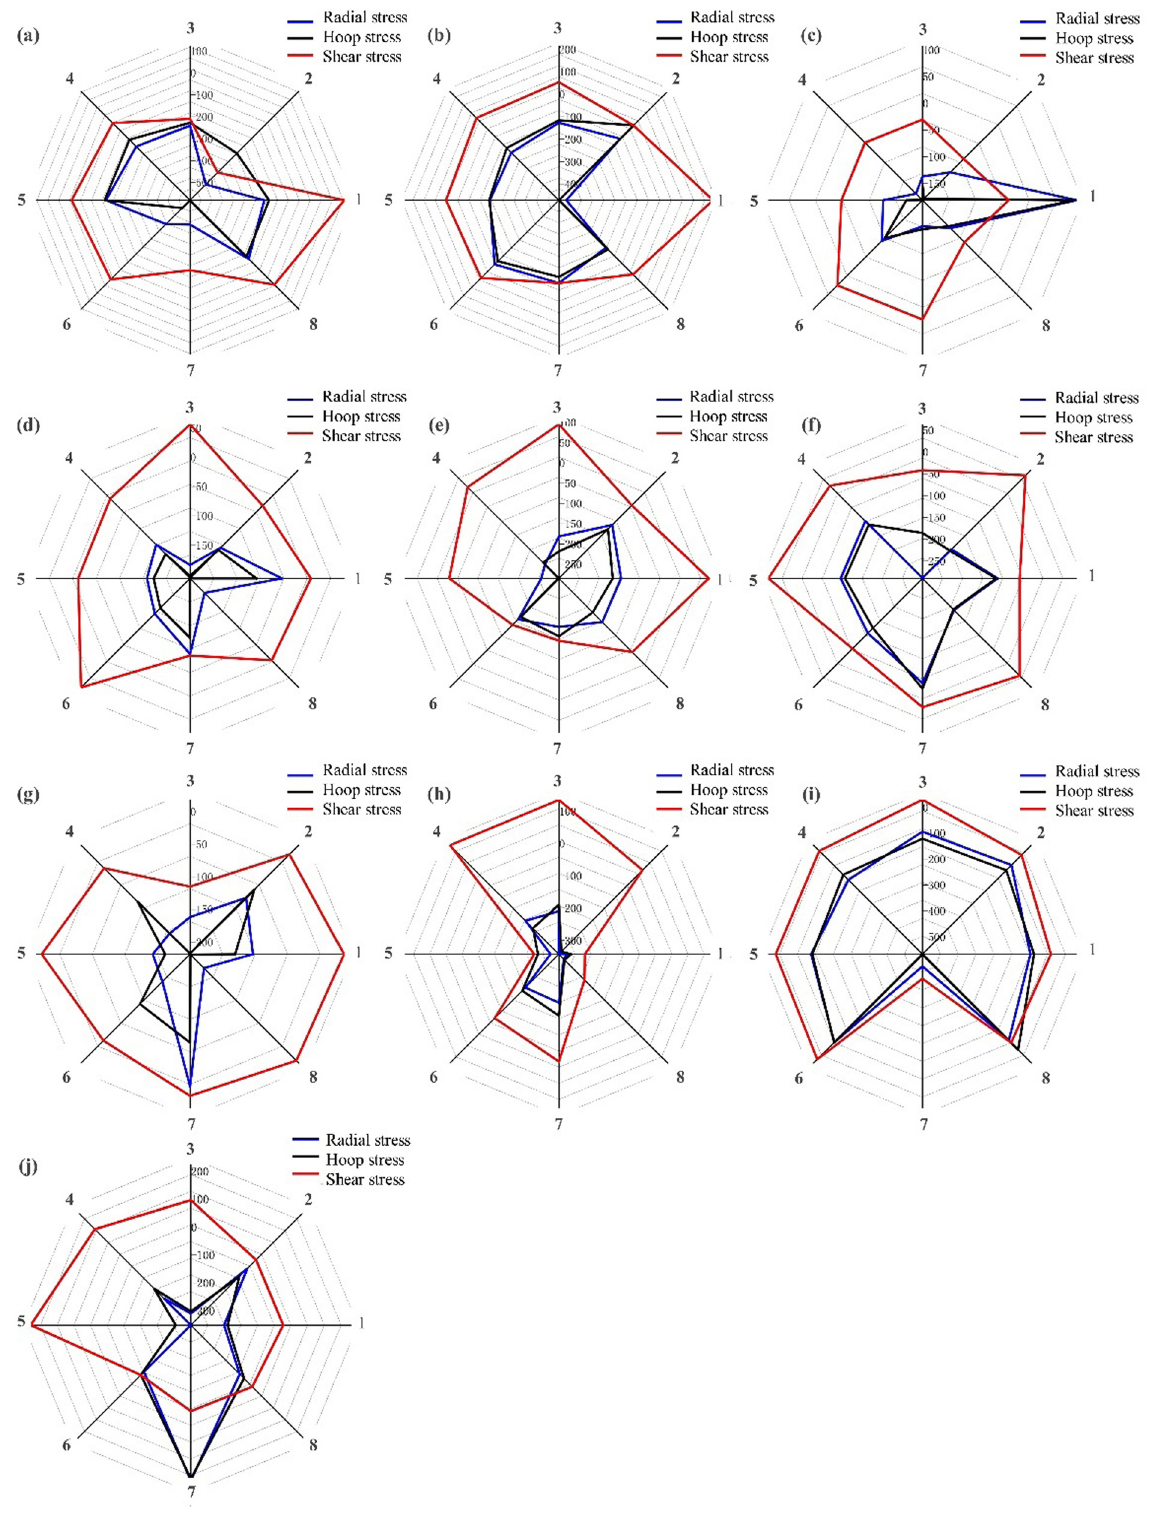
Figure 4: Residual stress at di ff erent depths: ( a ) 0.1 mm; ( b ) 0.2 mm; ( c ) 0.3 mm; ( d ) 0.4 mm; ( e ) 0.5 mm; ( f ) 0.6 mm; ( g ) 0.7 mm; ( h ) 0.8 mm; ( i ) 0.9 mm, and ( j ) 1.0